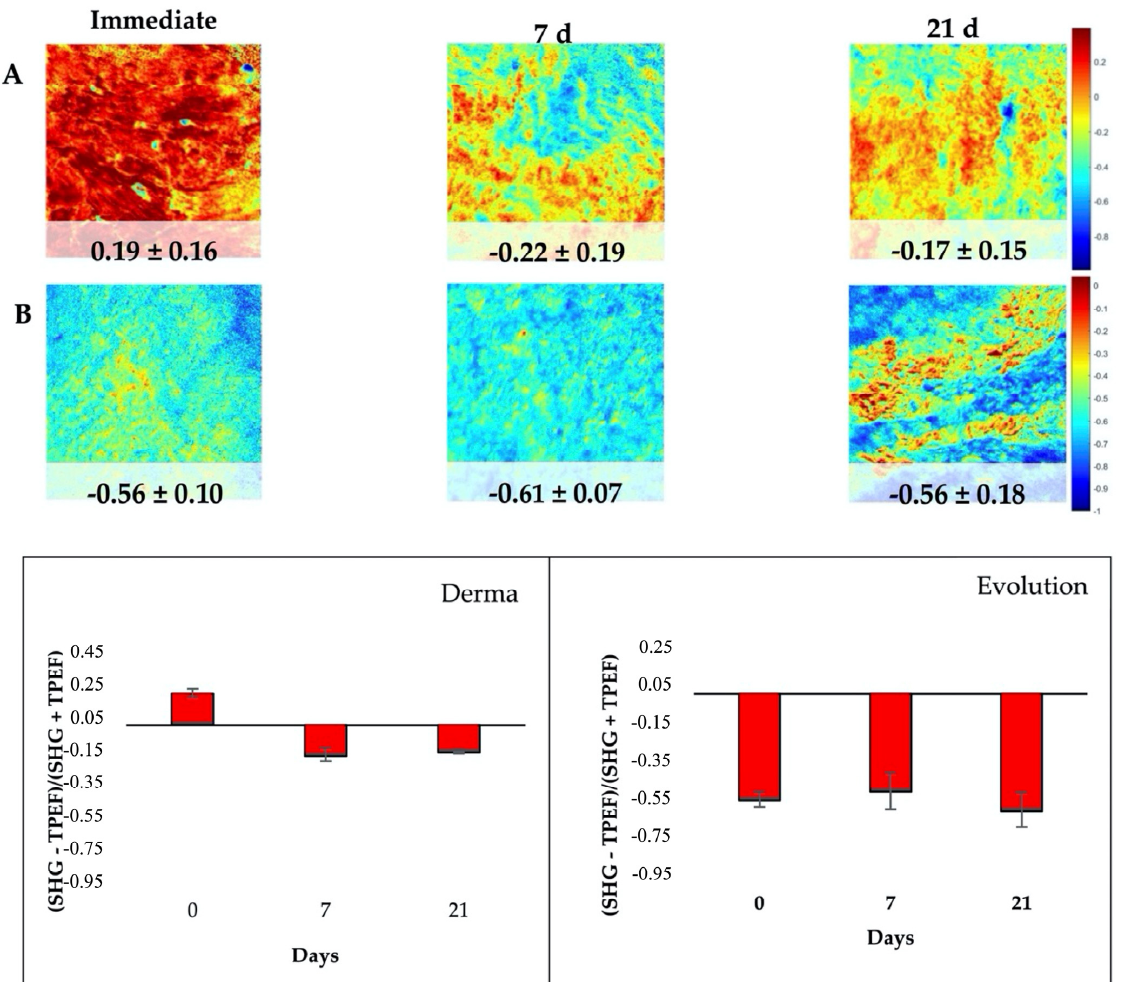
Figure 6. Aging Index map of Derma (( A ), upper panels) and Evolution (( B ), middle panels) at immediate (left column), 7 d (middle column) and 21 d (right column)of immersion. Plots show the mean and the standard deviation values of the index across the maps for all imaged areas for Derma (left) and Evolution (right) at the different immersion time-points.